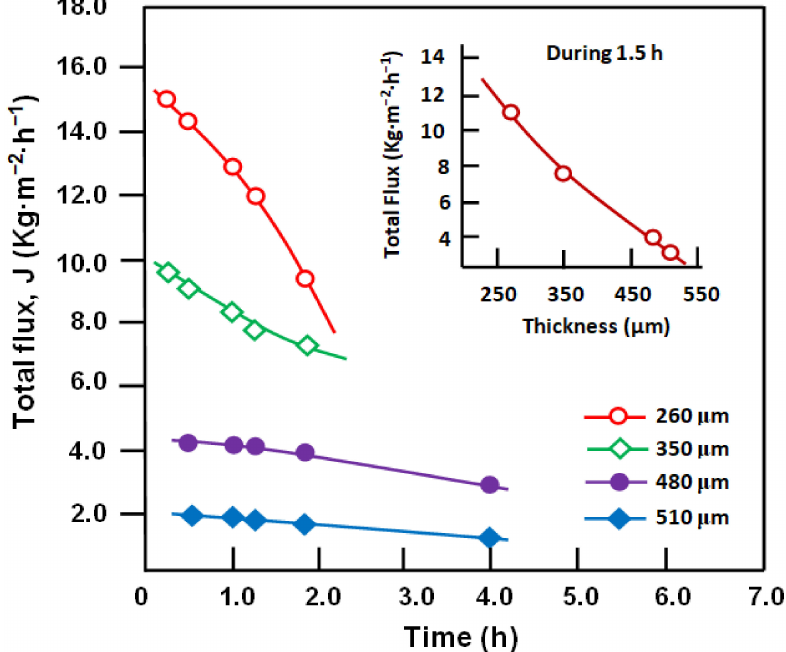
Figure 4. Variation of the total flux versus time obtained with different membrane thicknesses. Conditions: temperature, 20 ◦ C and stirring rate, 500 rpm.